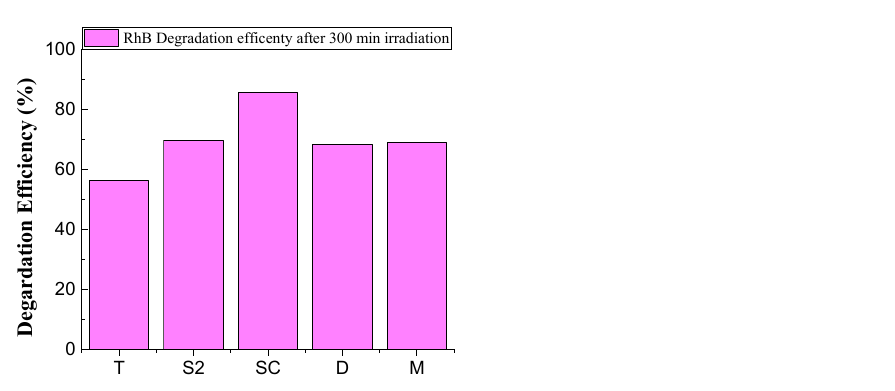
Figure 13. Photodegradation efficiency of the RhB aqueous solutions in the presence of T, S2, SC, D, and M samples after 300 min of UV light irradiation.